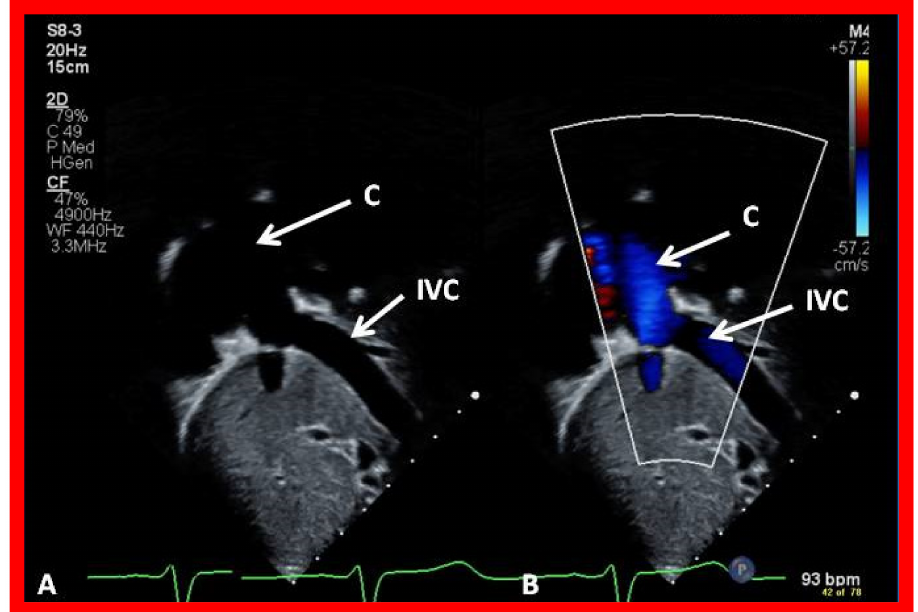
Figure 14. Echo images illustrating anastomosis of the inferior vena cava (IVC) with the conduit (C) by 2D ( A ) and color flow ( B ) imaging. Note widely patent IVC–C junction both by 2D ( A ) and by laminar flow with color Doppler ( B ). Reproduced from Reference